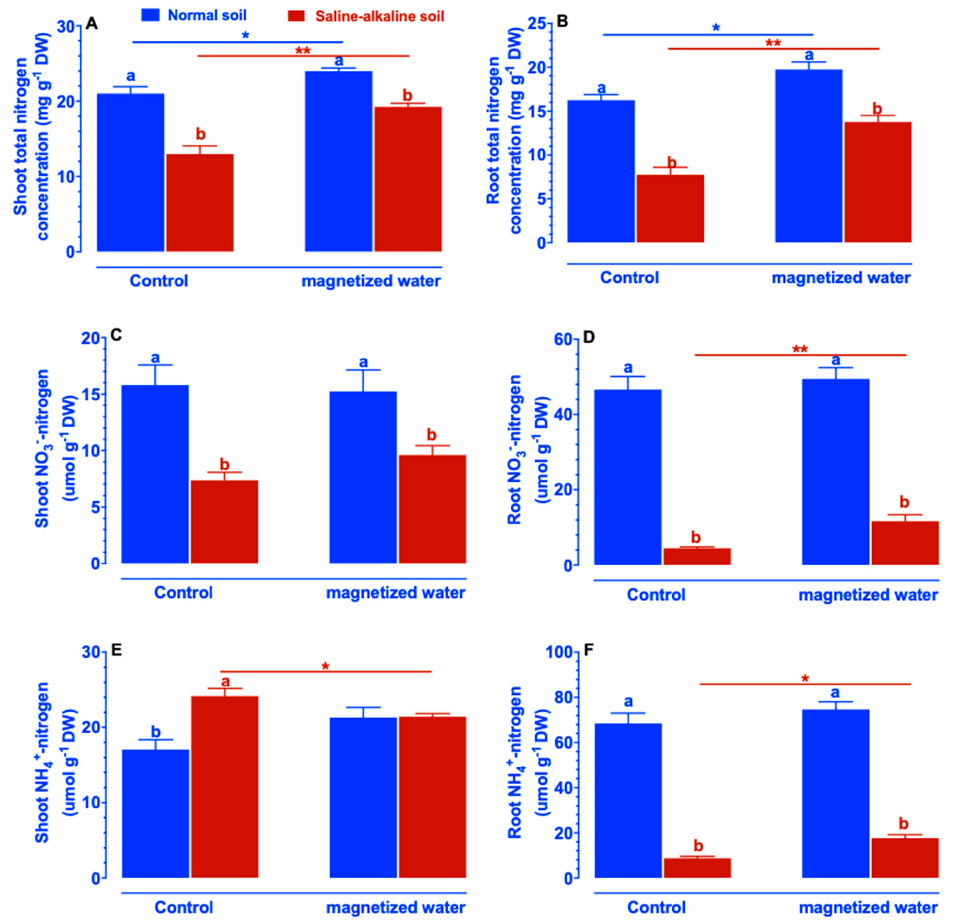
Figure 3. Effects of magnetized water on the concentration of total nitrogen ( A , B ), NO 3 − -nitrogen ( C , D ), and NH 4+ -nitrogen ( E , F ) in the shoots and roots of Nipponbare plants grown in normal and saline–alkaline stress soil. Treatments were as described in Figure 1. Means with different letters are significantly different ( p < 0.05) within the same treatment. Asterisks indicate significant differences between control and saline–alkaline stress of the same genotype, as determined by Student’s t -test (* p < 0.05, ** p < 0.01).